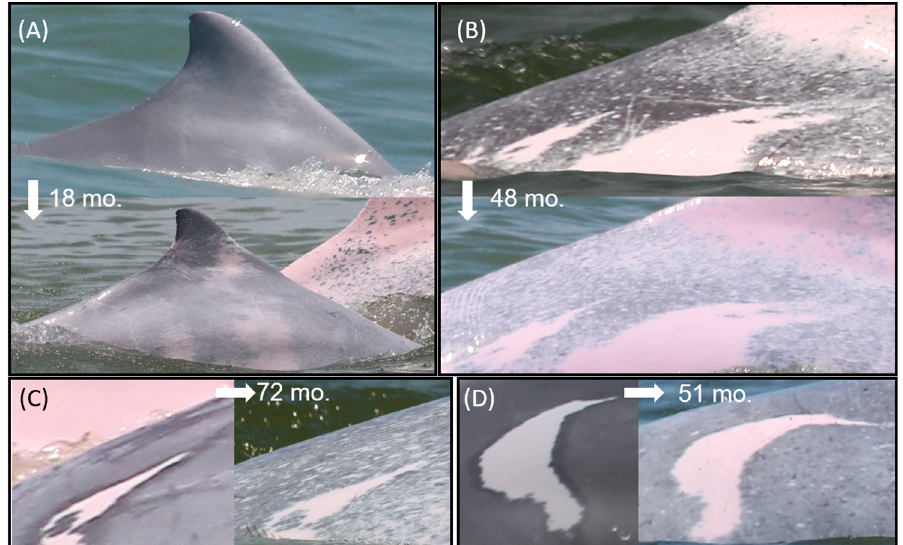
Figure 4. Ontogeny of the hypopigmentation of an Indo-Pacific humpback dolphin. ( A ) Continuous depigmentation process for a weaning juvenile; ( B–D ) examples of constant hypopigmentation observed for most of the individuals.